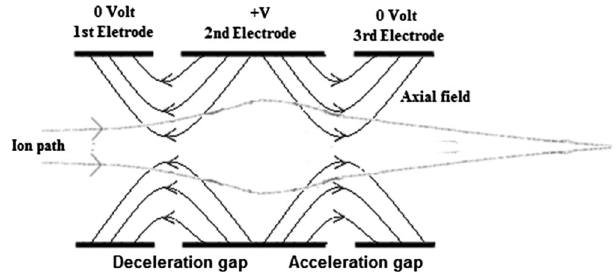
FIG. 36. Electric field lines and beam envelope in the Einzel lens region.